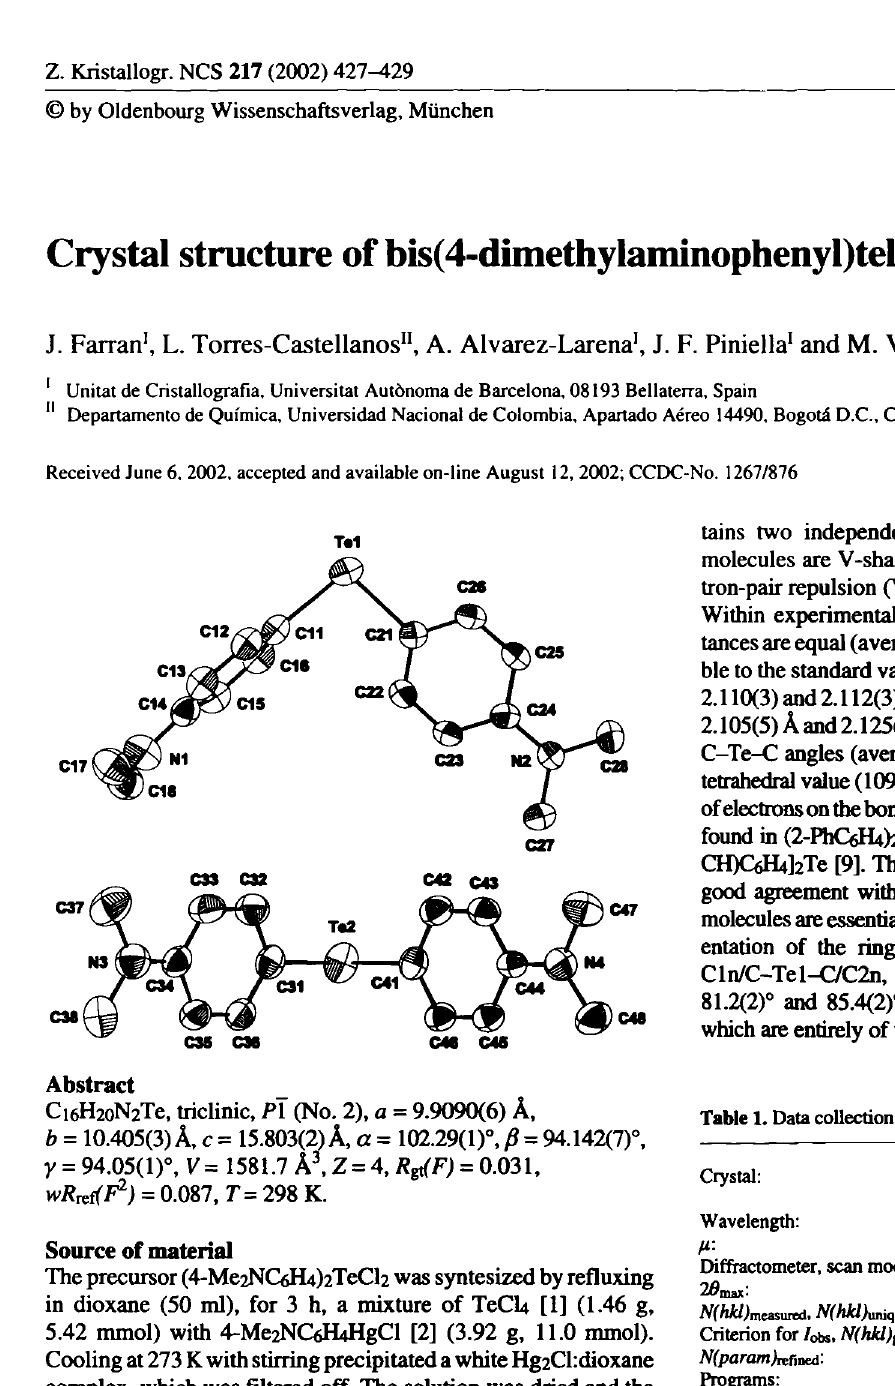
Table 2. Atomic coordinates and displacement parameters (in Â 2